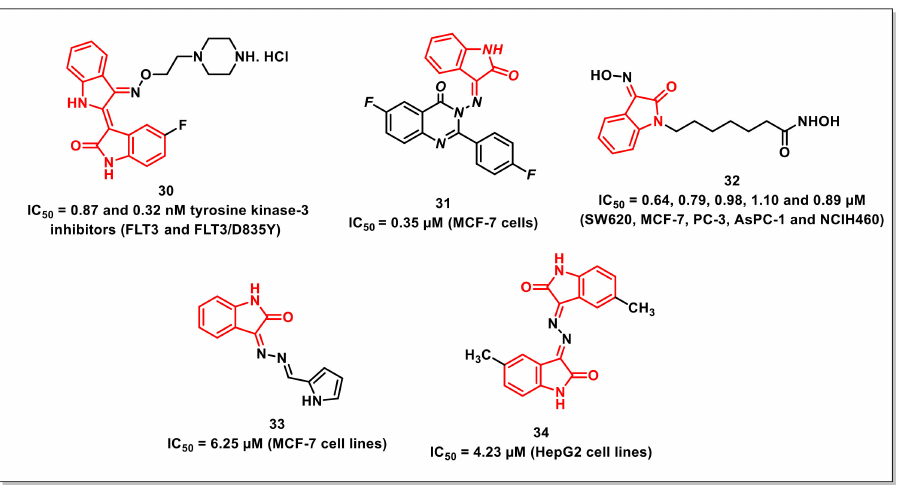
Figure 6. Antiproliferatives Schiff’s bases of